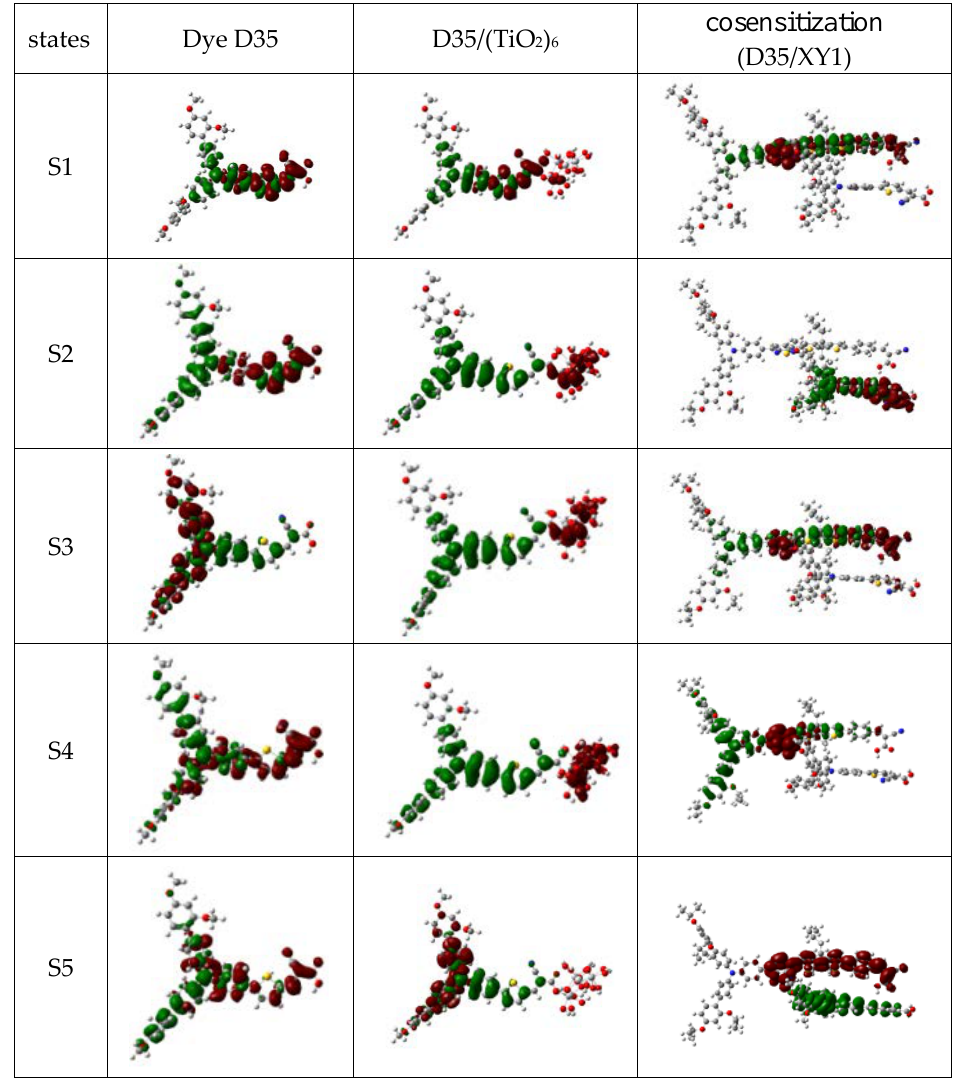
Figure 3. Simulated spectra for the dye in acetonitrile solvent, adsorption on TiO 2 and cosensitization.